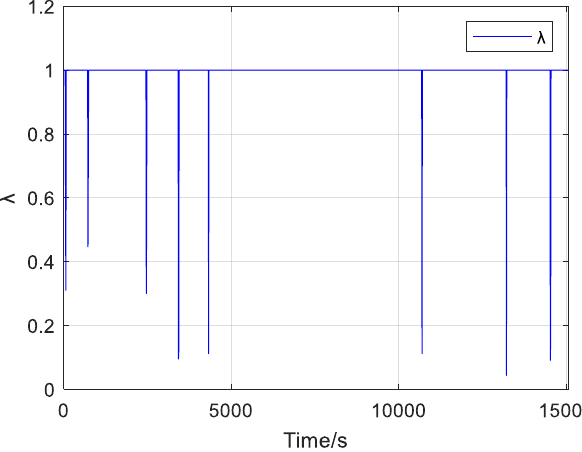
Figure 13. Real-time variation curve of the forgetting factor λ in the literature [16].